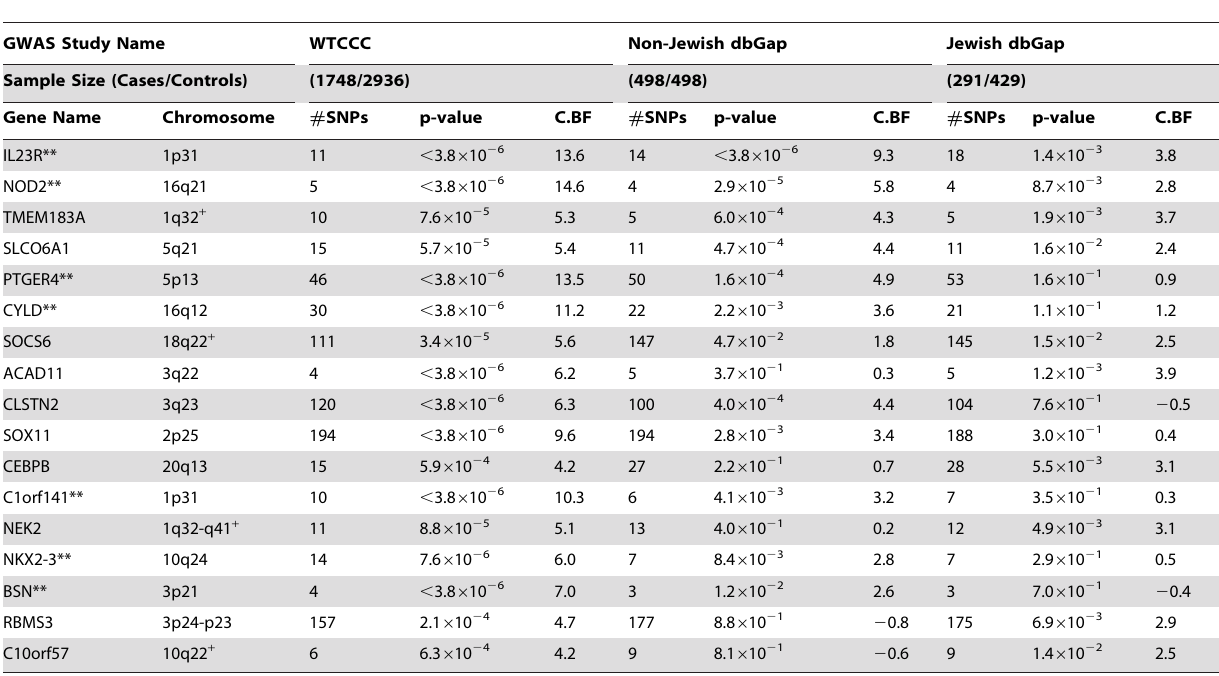
Table 3. Seventeen genes with the strong evidence for association with Crohn’s Disease risk in WTCCC and one or both of Non- Jewish and Jewish dbGap GWASs, with chromosomal locations, numbers of SNPs, approximate p-values, and Bayes